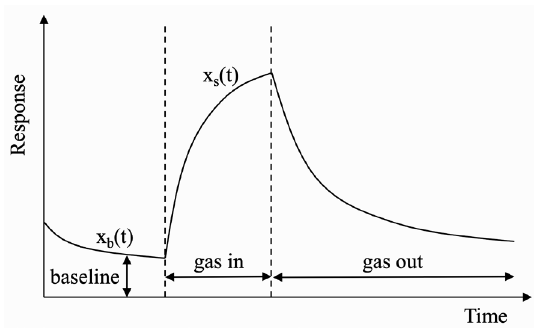
Figure 4. Dynamic response of gas sensor with baseline